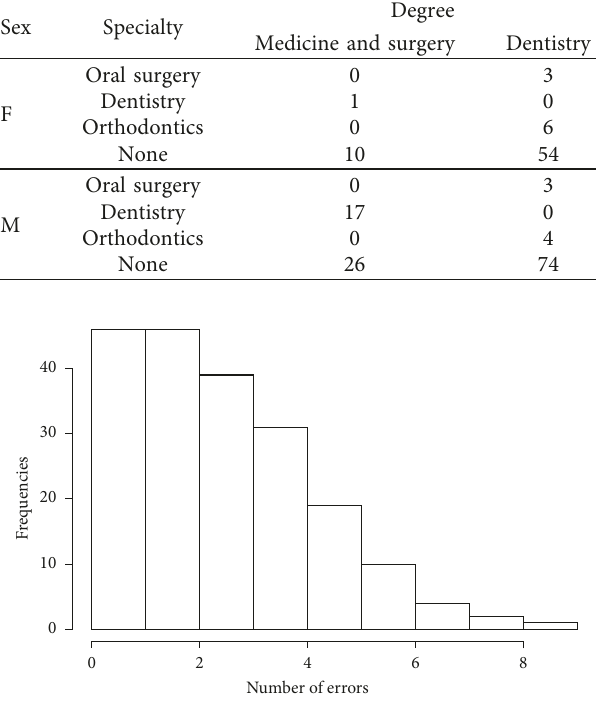
Figure 3: Histogram of number of errors that exhibits an asym- metric